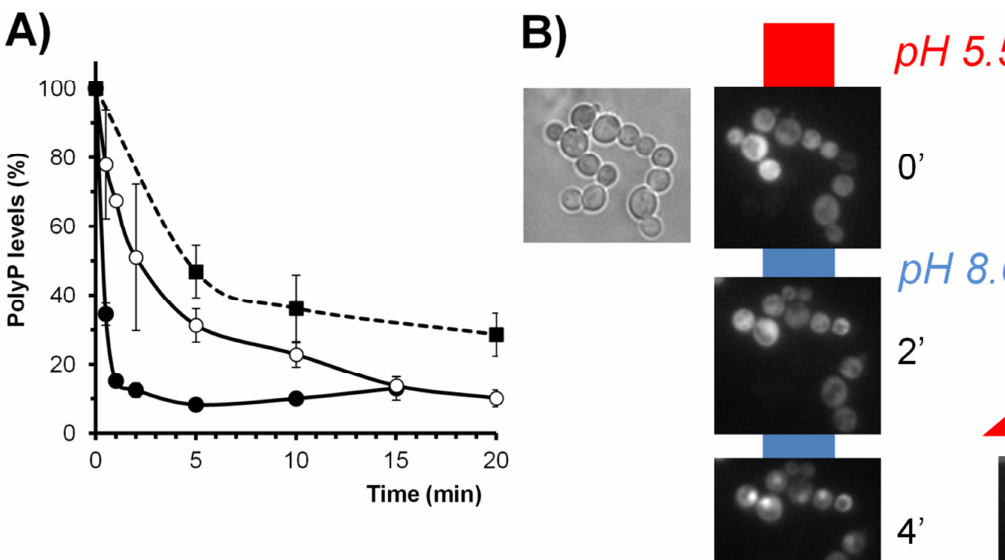
FIGURE 3: Effects of alkaline pH stress on phosphate metabolism. (A) Depletion of intracellular PolyP stocks upon alkalinization of the medium. Strains BY4741 (wild type, closed circles) and its isogenic derivative DCS30 ( ppn1 ppx1, open circles) were grown up to OD 600 0.6 and subjected to alkaline stress (pH 8.0) as in [82]. For comparison, in parallel experiments the wild type strain was subjected to phosphate limitation (0.1 mM Pi) as in [126]. Samples of the culture were taken at the indicated times and polyP content determined as in [126]. Data is expressed as percentage relative to the levels just prior initiation of the stress and are mean ± SEM from 3 independent experiments. (B) Reversible cytosolic-nuclear transfer of Pho4 upon modification of the extracellular pH. Wild type strain DBY746 was transformed with plasmid Pho84-GFP, carrying a C-terminally GFP-tagged version of PHO4 , and grown until OD 660 0.6 in Verduyn medium [127]. Aliquots were injected into a CellASIC ® ONIX Y04C-02 microfluidics chamber and the pH of the medium changed with time as indicated in the figure. Images were collected with a Nikon Eclipse TE2000-E microscope using a FITC filter and a Hamamatsu ORCA-ER